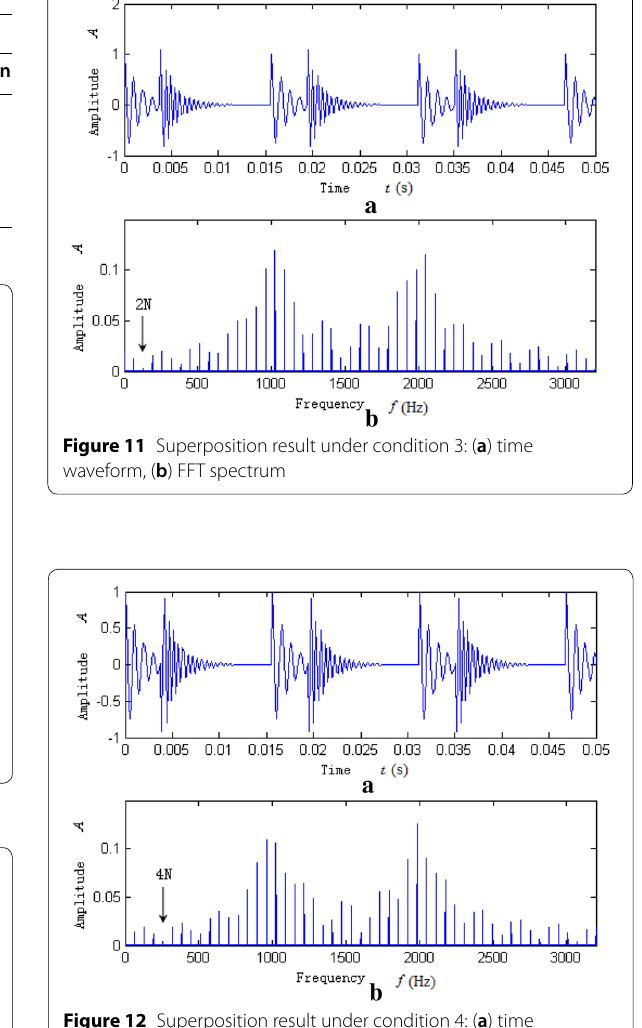
Figure 12 Superposition result under condition 4: ( a ) time waveform, ( b ) FFT